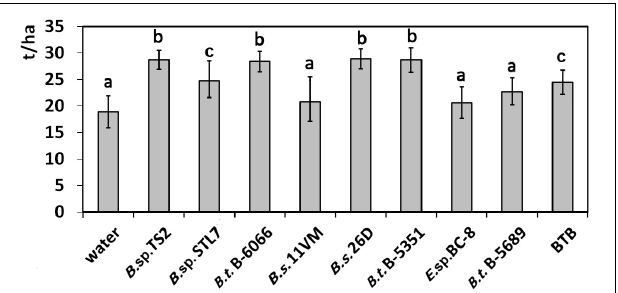
FIGURE 6 | Effect of bacterial agents and Bitoksibacilline (BTB) treatments of potato plants on the total potato yield. Data represented as mean values ± standard error; values followed by the same alphabet within a column are not significantly different from each other according to Tukey’s honestly significant difference (HSD) multiple-range test at P < 0.05.